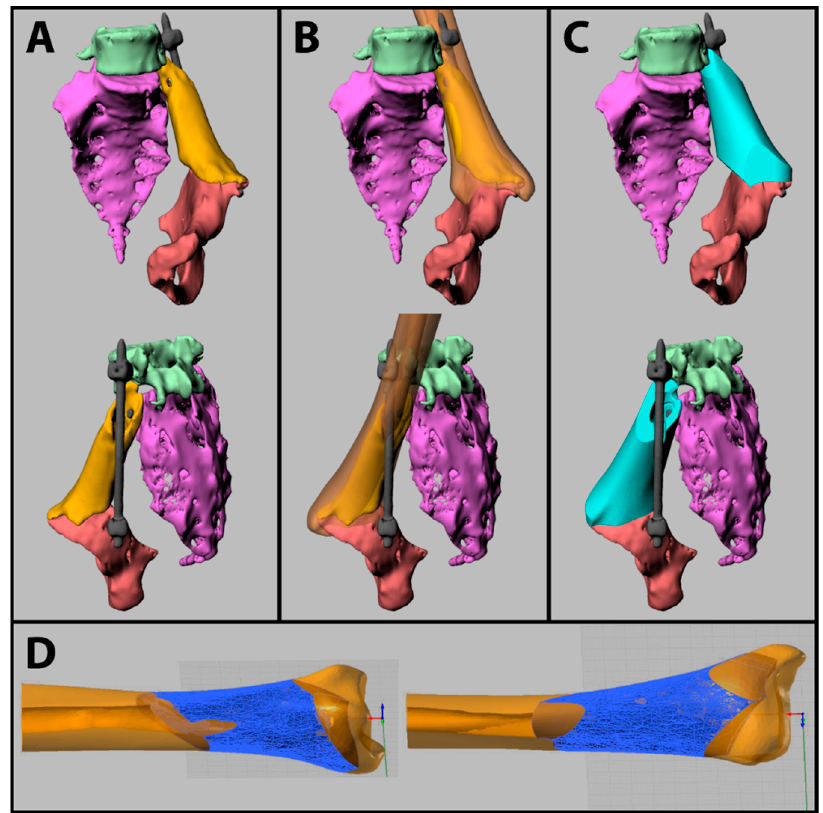
Figure 2. ( A ) Segmented files as imported from 3D Slicer; implanted allograft (yellow); resected hemipelvis (red); resected sacrum (purple); L5 vertebra (green); bars and screws (grey). ( B ) Overlap of the selected allograft model (brown). ( C ) Designed allograft (light blue) in place. ( D ) Designed allograft (blue) vs. allograft model (brown).